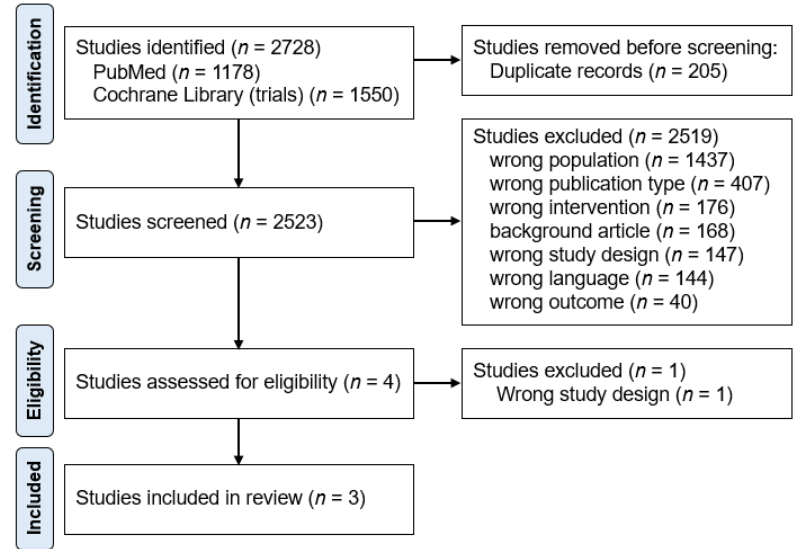
Figure 1. Flow chart of the study process. Through searching databases, 2728 reports were found. After removing duplicates, 2523 reports were screened, of which 2519 were excluded. A total of four studies underwent full-text review, and three studies were included in the review.